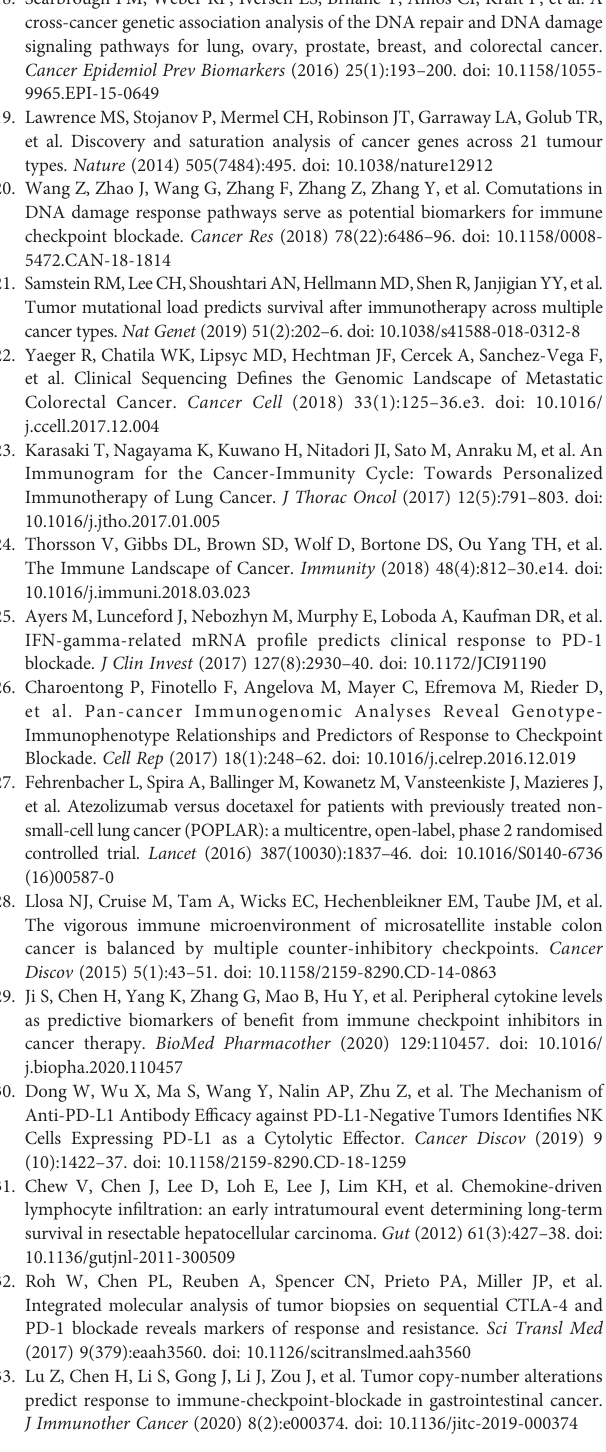
(E) LOH and CNV between DDR Mut and WT groups in MSS subgroup. nsP>0.05, * P<0.05, ** P<0.01, ***P<0.001, ****P<0.0001. Supplementary Figure 6 | The association between the TMB value and the incidence of DDR mutation, the MSI status and the incidence of DDR mutation, PD-